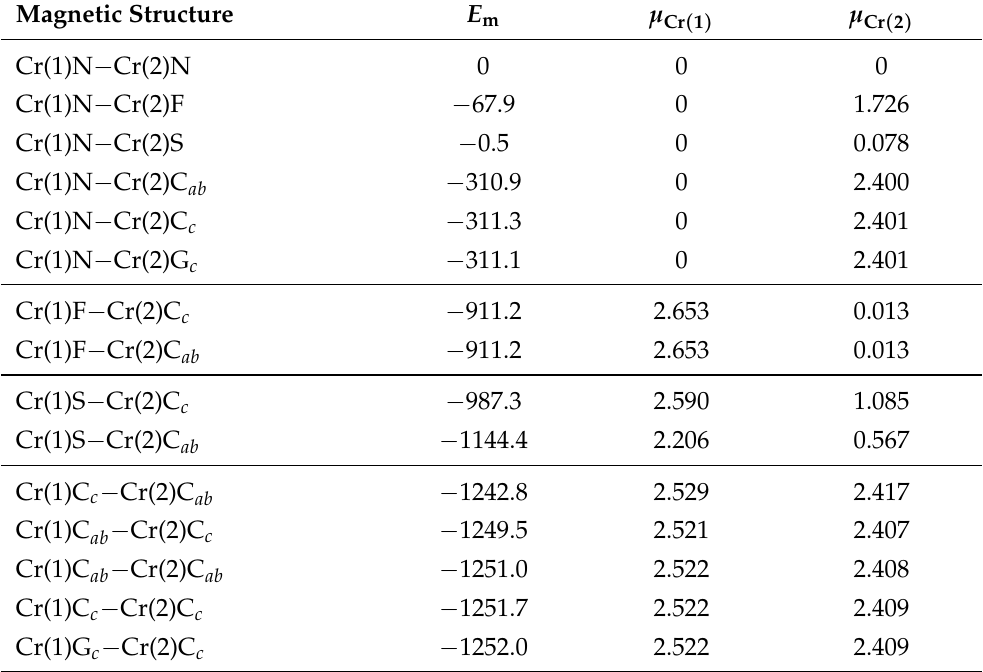
Table 3. Calculated magnetic energy E m (in meV/f.u.) relative to non-magnetic (N) state and the corresponding magnetic moment µ Cr (in µ B ) of different magnetic structures of Sr 2 Cr 2 AsO 3 . F, S, C, and G denote ferromagnetic, striped AFM, C-type AFM, and G-type AFM structures, respectively. The subscripts ab and c tell the spin